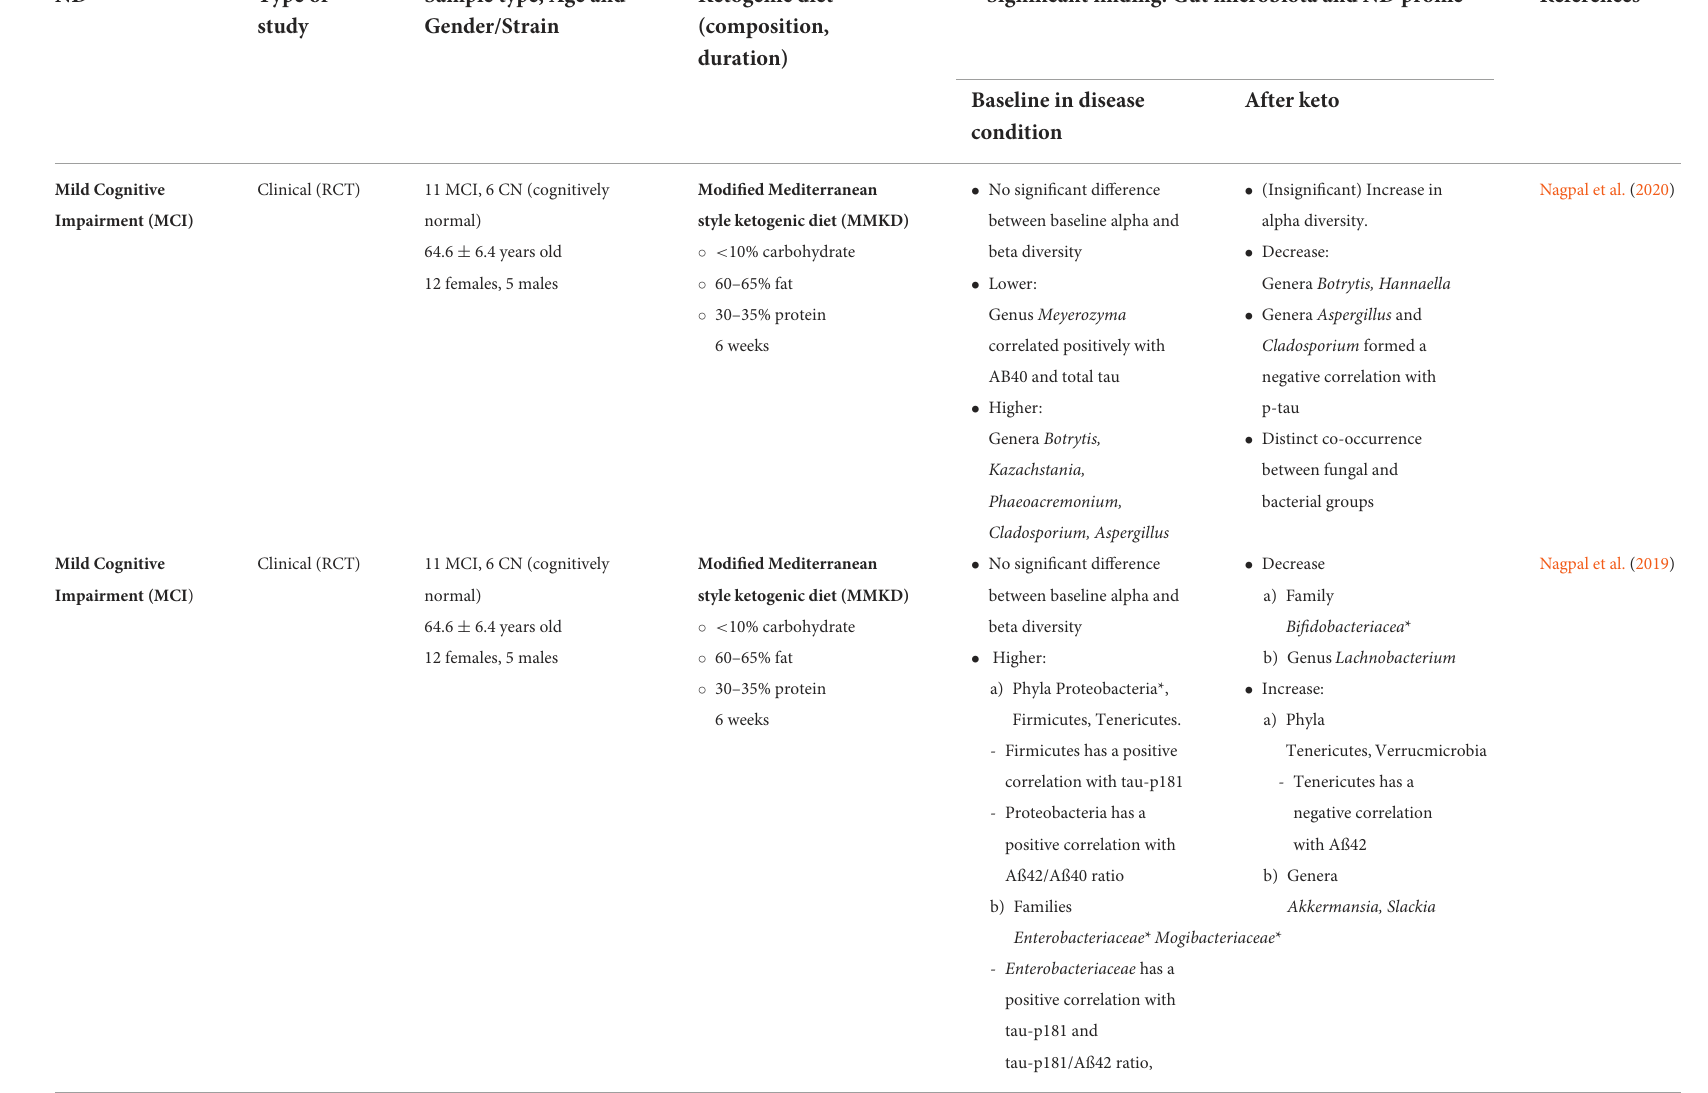
TABLE 1 Summary of study characteristics and significant findings of ketogenic diet in association with gut microbiota and neurodegenerative